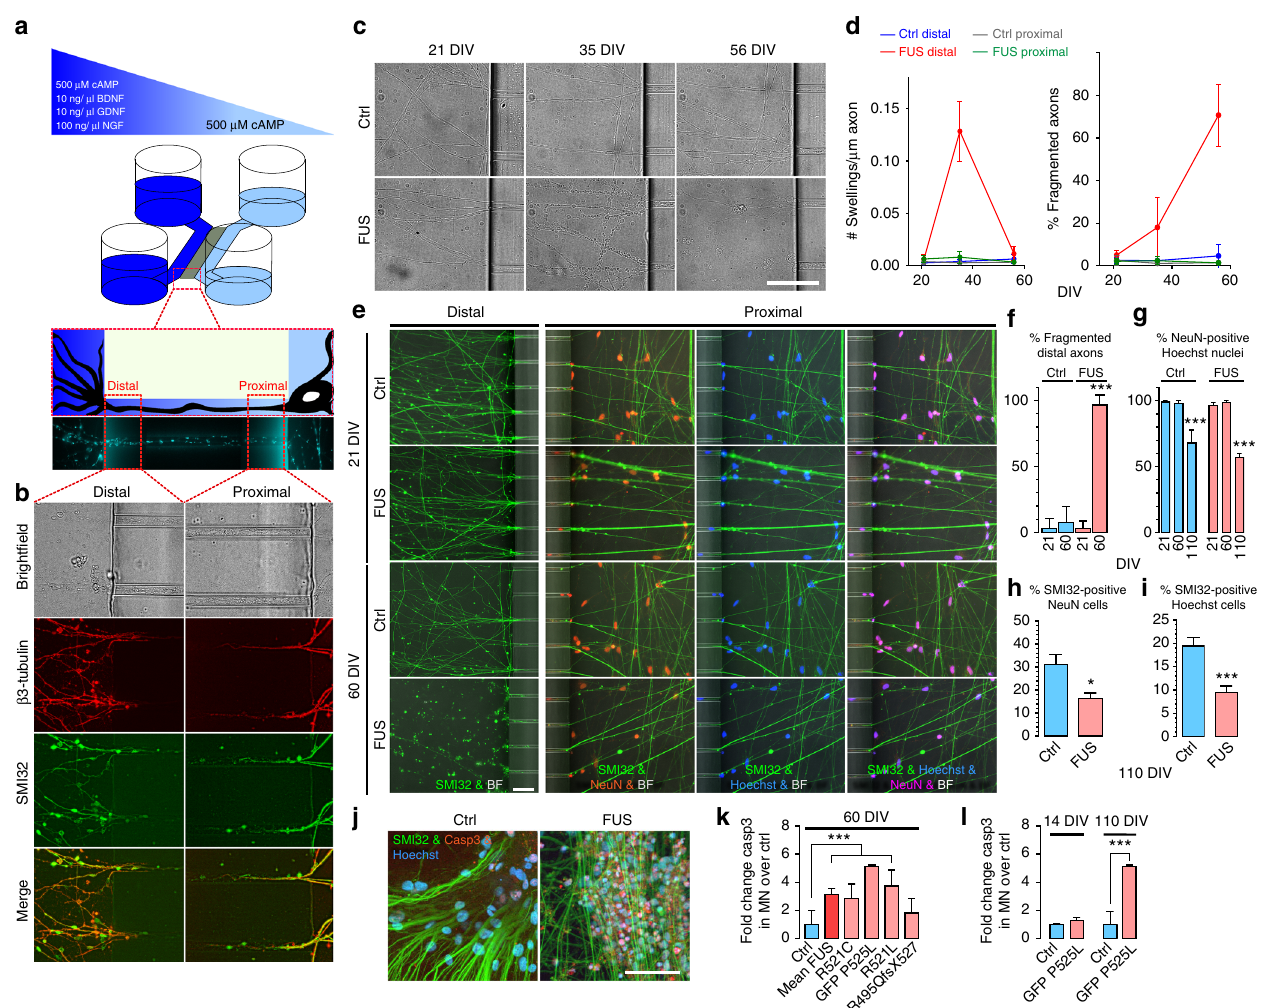
Fig. 2 Sequential development of neurodegeneration in FUS-ALS MNs. a Cells were differentiated and afterwards seeded to one side (light blue). Directed growth of axons through 900 µ m long microchannels to the other side (dark blue) was realized by the application of a volume and maturation factor gradient functioning as a guidance cue. For a standardized statistical readout the “ Distal “ and “ Proximal “ Windows were de fi ned. b Phase contrast and ICC of MN (representative example: Ctrl1, Table 1) cultivated in the MFCs. All grown-through axons were positive for β III Tubulin and SMI32, labeling them as originated from MNs, bar: 20 µ m. c Bright fi eld (BF) images acquired over aging of MN at the distal MFC exit revealed prominent axonal swelling and fragmentation beyond 21 DIV in FUS-GFP P525L as opposed to FUS-GFP WT control cells, bar: 50 µ m. d Quanti fi cation of c , left: count swellings, right: % fragmented distal axons, N = 10, error bars = STDEV. e IF images acquired over aging of MN at the distal exit versus proximal entry site with distal stainings for SMI32 (MN marker Neuro fi lament H) and proximal stainings for NeuN (neuronal nuclear marker) and Hoechst, Ctrl: FUS-GFP WT, FUS: FUS- GFP P525L. Note the complete loss of SMI32-positive distal axons (i.e. fragmentation) in FUS at 60 DIV as opposed to healthy control cells whereas the soma and network integrity remained intact at the proximal site, indicating a dying-back in FUSmts, bar: 50 µ m. f – i Quanti fi cation of e and in addition at 110 DIV, f distal axon integrity (% fragmented SMI32-positive axons), g % NeuN-positive Hoechst nuclei, h % SMI32-positive NeuN cells and i % SMI32- positive Hoechst cells, N = 10. j Increased apoptosis in FUS-GFP P525L MNs at 60 DIV as indicated by Caspase 3 IF staining (see Supplementary Fig. 10 for detailed gallery). k Quanti fi cation of j and all other mutant FUS MNs (see Table 1) at 60 DIV, N (ctrl) = 31, N (mean FUS) = 41, N (R521C) = 8, N (GFP- P525L) = 2, N (R521L) = 10, N (R495QfsX527) = 10, error bars = STDEV. l Isogenic ctrl/P525L MNs show increase of Caspase 3 MNs in the mutant line during cellular aging (14 versus 110 DIV), N = 8. All data are plotted as mean, statistics ( f – i , k , l ): one-way ANOVA with post-hoc Bonferroni test (*, **, *** P values of 0.05, 0.01, and 0.001, error bars =